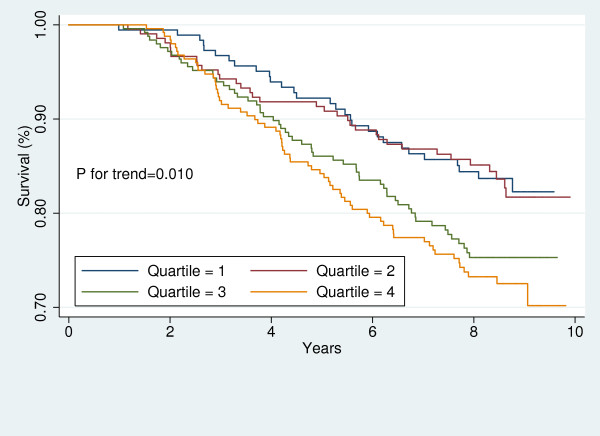
Kaplan-Meier curves for incident CVD across LAP quartiles in men with global CVD risk 20% or more.